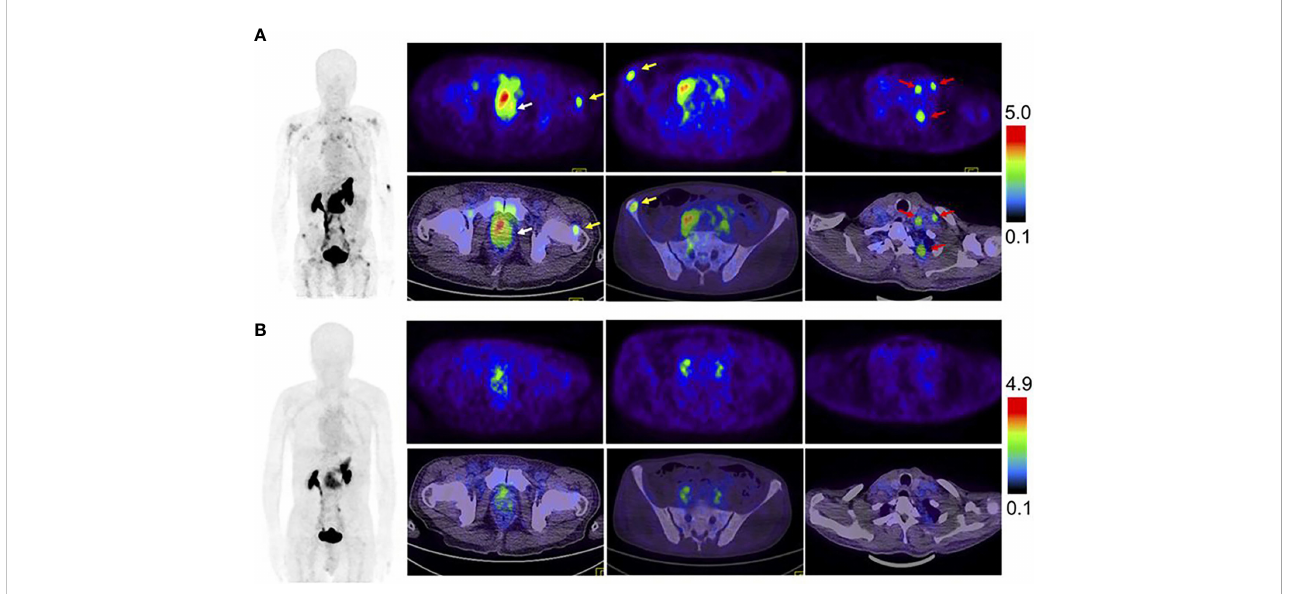
FIGURE 3 Comparison of 68 Ga-RM26 PET/CT (A) , and 68 Ga-BBN PET/CT (B) in a 73-y-old man diagnosed as having PCa (white arrow) with lymph node involvement (red arrow) and bone metastasis (yellow arrow) before prostatectomy. 68 Ga-RM26 PET/CT detected primary tumors, multiple lymph node involvement, and bone metastasis lesion, whereas those lesions showed much lower uptake on 68 Ga-BBN PET/CT. Reprinted with permission from Zhang et al. (70). Copyright © 2018 by the Society of Nuclear Medicine and Molecular